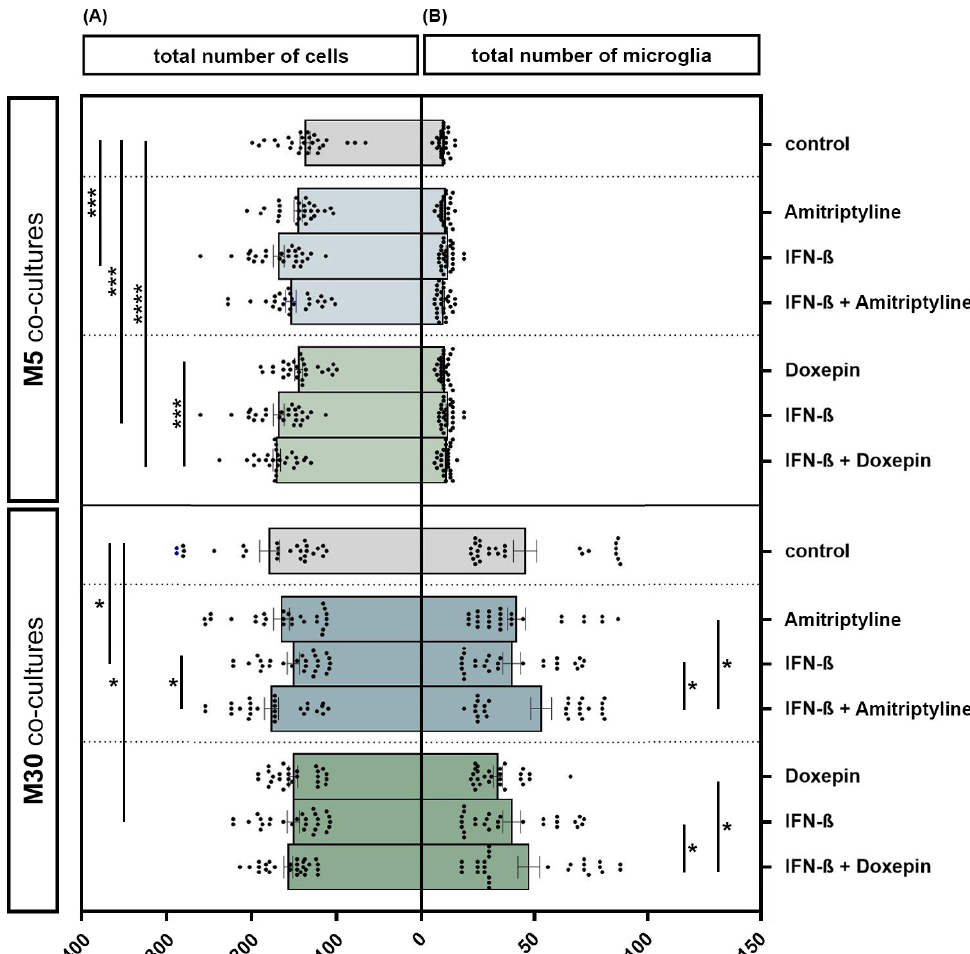
Figure 3. The total number of cells ( A ) and microglia ( B ) detected by immunocytochemistry in physiological (M5) and pathological (M30) co-cultures after incubation with 10 ng/mL amitriptyline, 10 ng/mL doxepin and 2000 U/mL interferon- β (IFN- β ). In the physiological (M5) co-cultures, incubation with IFN- β for 22 h resulted in a significant increase in the cell number by 22.2% ( n = 27) compared to the control ( A ). The additional incubation of IFN- β pre-treated M5 co-cultures with doxepin for 2 h led to an overall increase in the total cell number by 23.7% ( n = 27) compared to the control. The direct comparison shows that the incubation of IFN- β and doxepin led to a sig- nificant increase in the cell number by 17% compared to incubation with doxepin alone ( n = 27). In the M30 co-cultures, however, incubation with IFN- β led to a significant reduction in the total cell number by 15% compared to the control ( n = 27). In contrast, the additional incubation with ami- triptyline again led to a significant increase in the cell number by 16.9% ( n = 27) compared to incu- bation with IFN- β alone ( A ). Incubation with 10 ng/mL amitriptyline, 10 ng/mL doxepin or 2000 U/mL IFN- β did not lead to significant changes in the number of microglia in the physiological M5 co-cultures ( B ). In the pathological M30 co-cultures, pre-incubation with IFN- β and subsequent in- cubation with amitriptyline or doxepin led to a significantly increased number of microglia com- pared to incubation with amitriptyline, doxepin or IFN- β alone ( n = 27). Untreated co-cultures were used as controls. The individual experimental conditions were compared by two tailed t-test. Differences were considered significant at p < 0.05: *, p < 0.001: ***, p ≤ 0.0001: ****. 3.3. Effects of Doxepin, Amitriptyline and IFN- β on Microglial Activation under Physiological and Pathological Conditions Incubation of the physiological M5 co-cultures with 10 ng/mL amitriptyline or 10 ng/mL doxepin for 2 h, or with 2000 U/mL IFN- β for 22 h, showed a significant increase